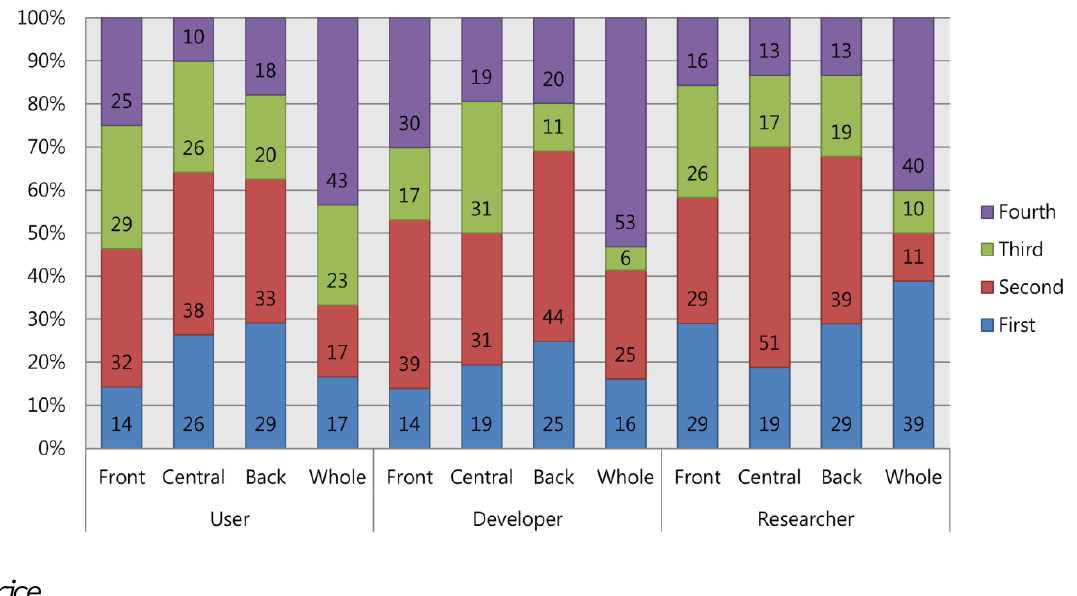
Figure 9. Preference order for sensor positions. A detailed illustration of sensor position is presented in the